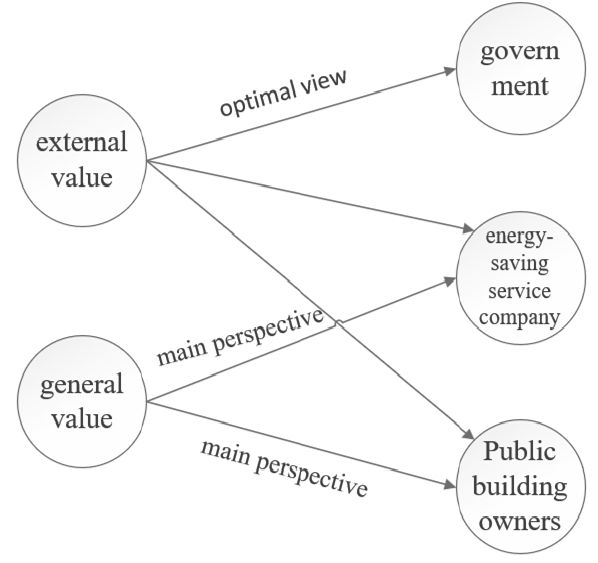
Figure 3. Optimal perspectives of each interest body.